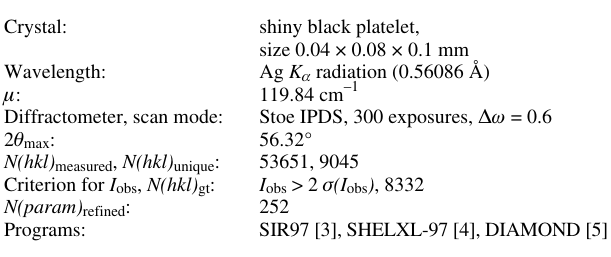
Table 1. Data collection and handling.